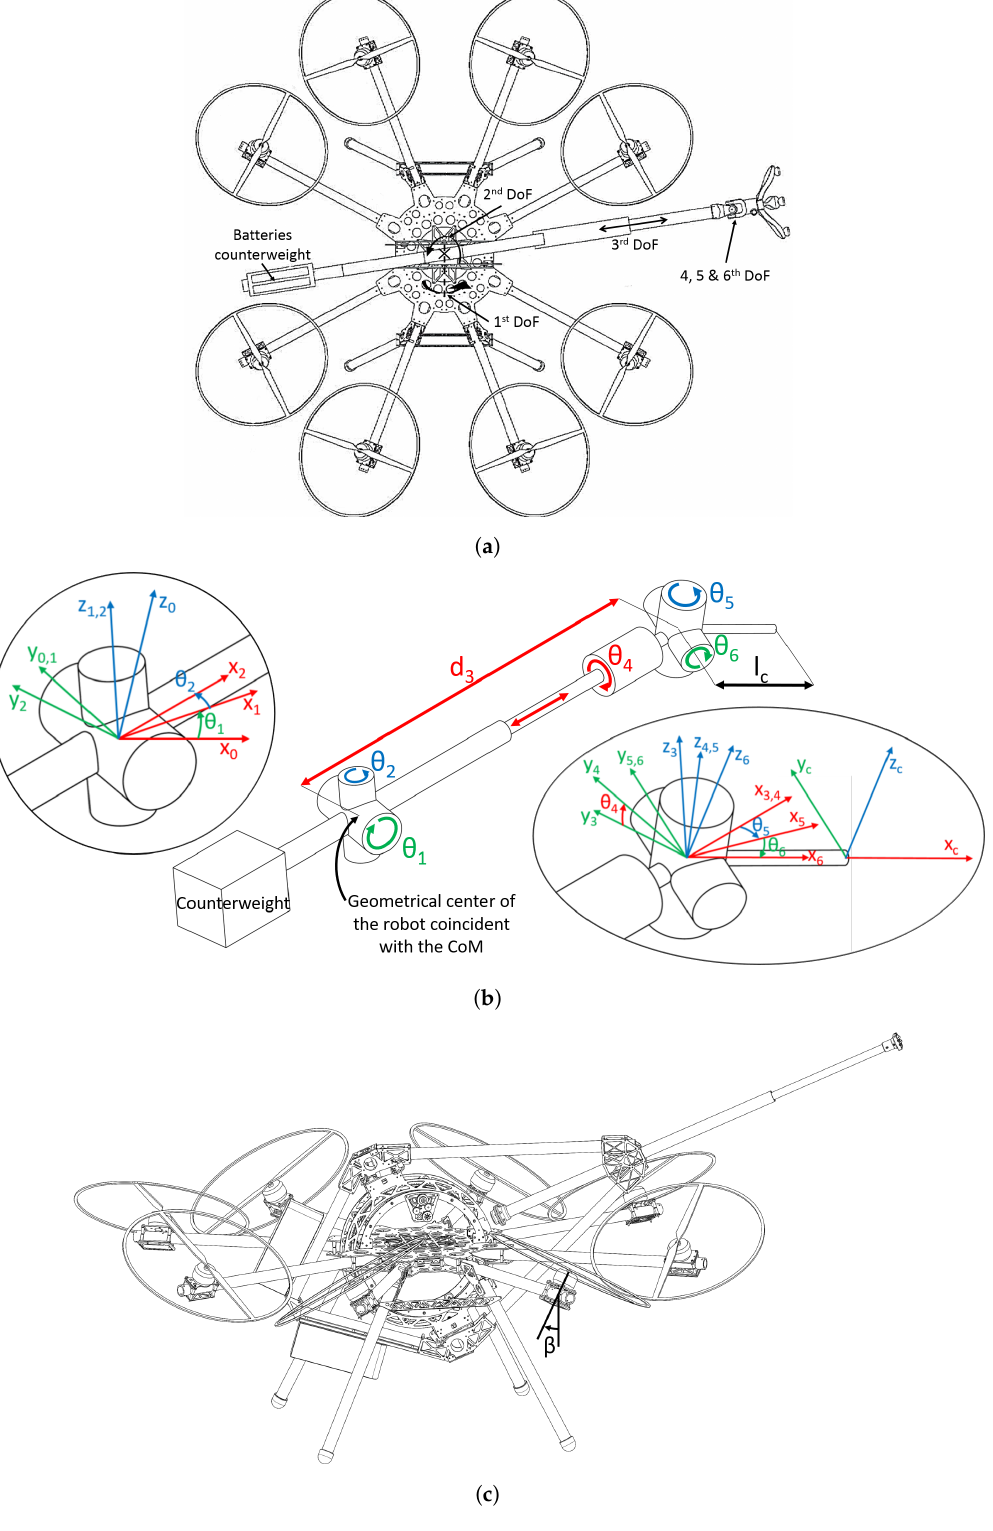
Figure 4. Different schemes of the proposed aerial robot showing its kinematic representation. ( a ) Drawing of AeroX. Its size is 170 × 230 cm. ( b ) Scheme of the robotic contact device showing its six joints and the reference systems for each DoF. ( c ) Drawing of the aerial robot. The tilted-rotor configuration can be noticed. Each rotor is alternatively tilted a fixed angle β = 1/6 rad around its motor